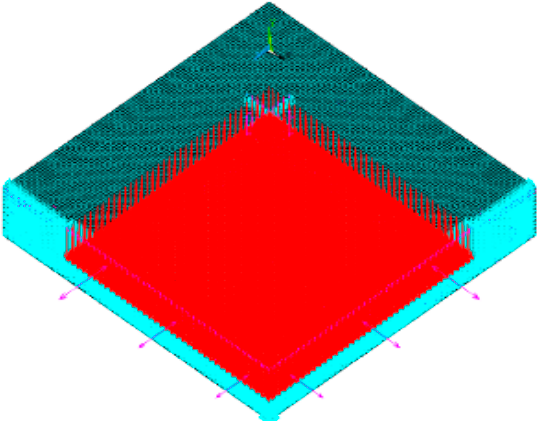
Figure 31. Modeling of uniform load.